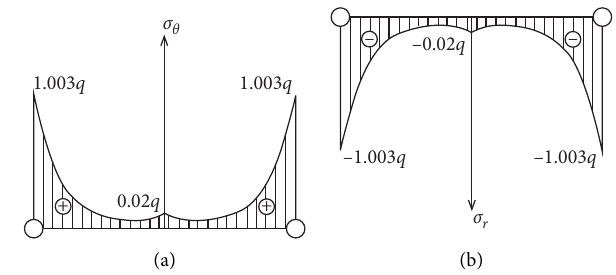
Figure 2: Stress potential diagram under static action.